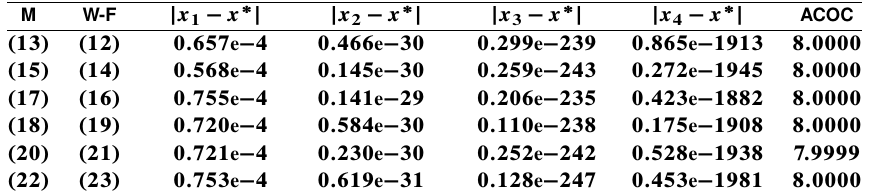
Table 1. Comparison for f.x/ D ln .1 C x 2 / C e x 2 (cid:0) 3x sin .x/;x (cid:3) D 0;x 0 D 0:35 , for different methods (M) and weight functions (W-F).